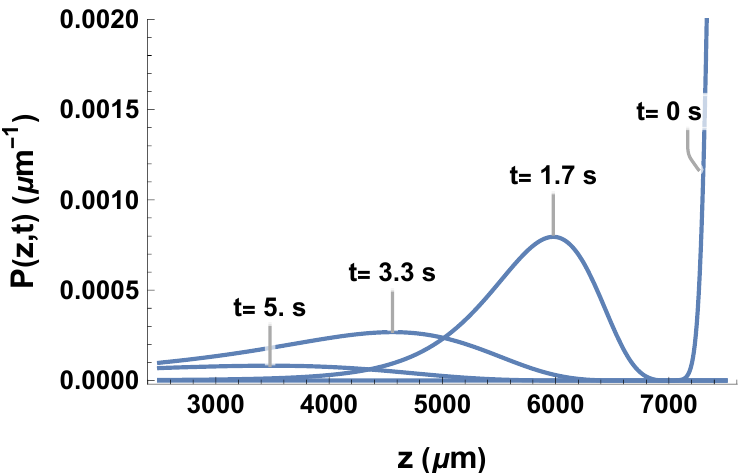
Figure 9. FeNP aggregates crossing a layer of corn syrup under the effects of diffusion, gravity, and an MF.